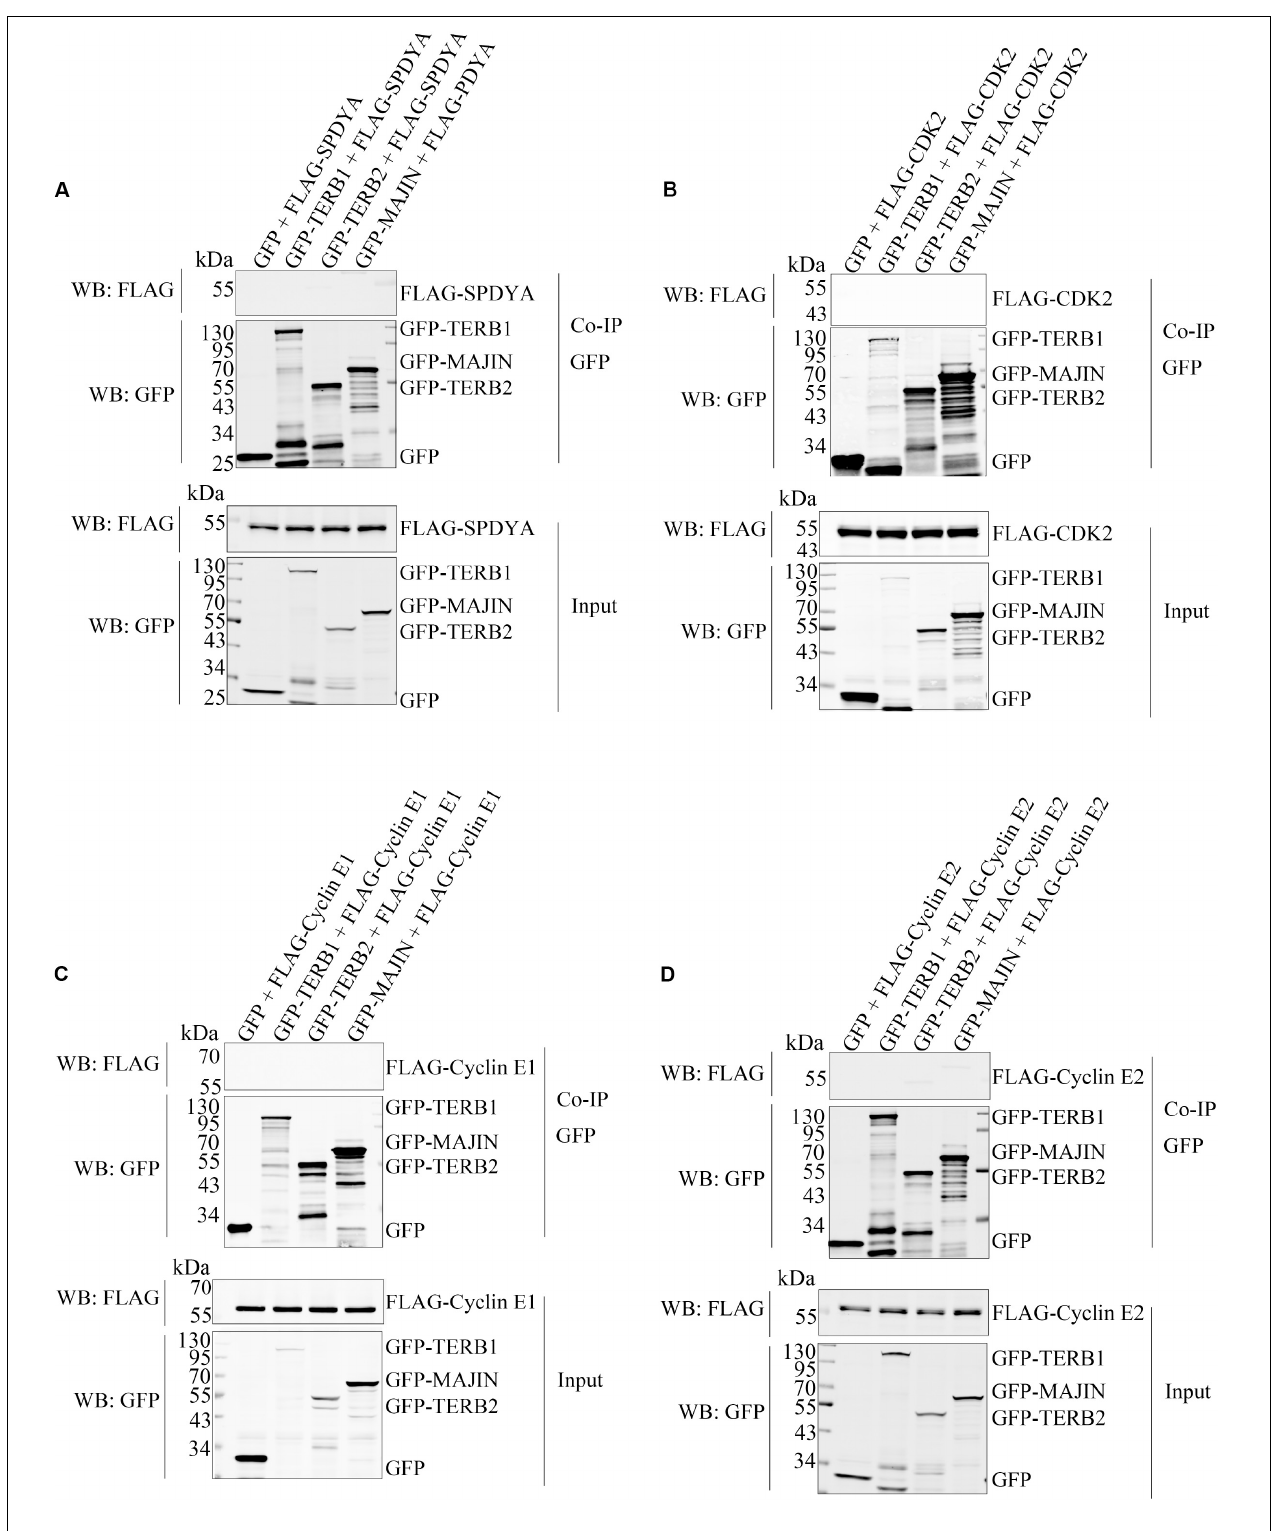
FIGURE 4 | SPDYA, CDK2, and Cyclin E are not associated with TTM complex. The expression plasmids of GFP, GFP-TERB1, GFP-TERB2, and GFP-MAJIN were co-transfected with FLAG-SPDYA (A) , FLAG-CDK2 (B) , FLAG-Cyclin E1 (C) , or FLAG-Cyclin E2 (D) into HEK293T cells. Cells were harvested and lysed, 10% cell lysates were used as input, and the remained lysates were incubated with GFP-Trap. After incubation, the GFP-Trap was washed to remove unbound proteins. Then samples of input and Co-IP were subjected to western blotting.